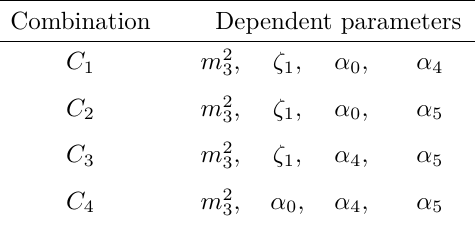
Table 1 . The dependent parameters associated to the different combinations C i